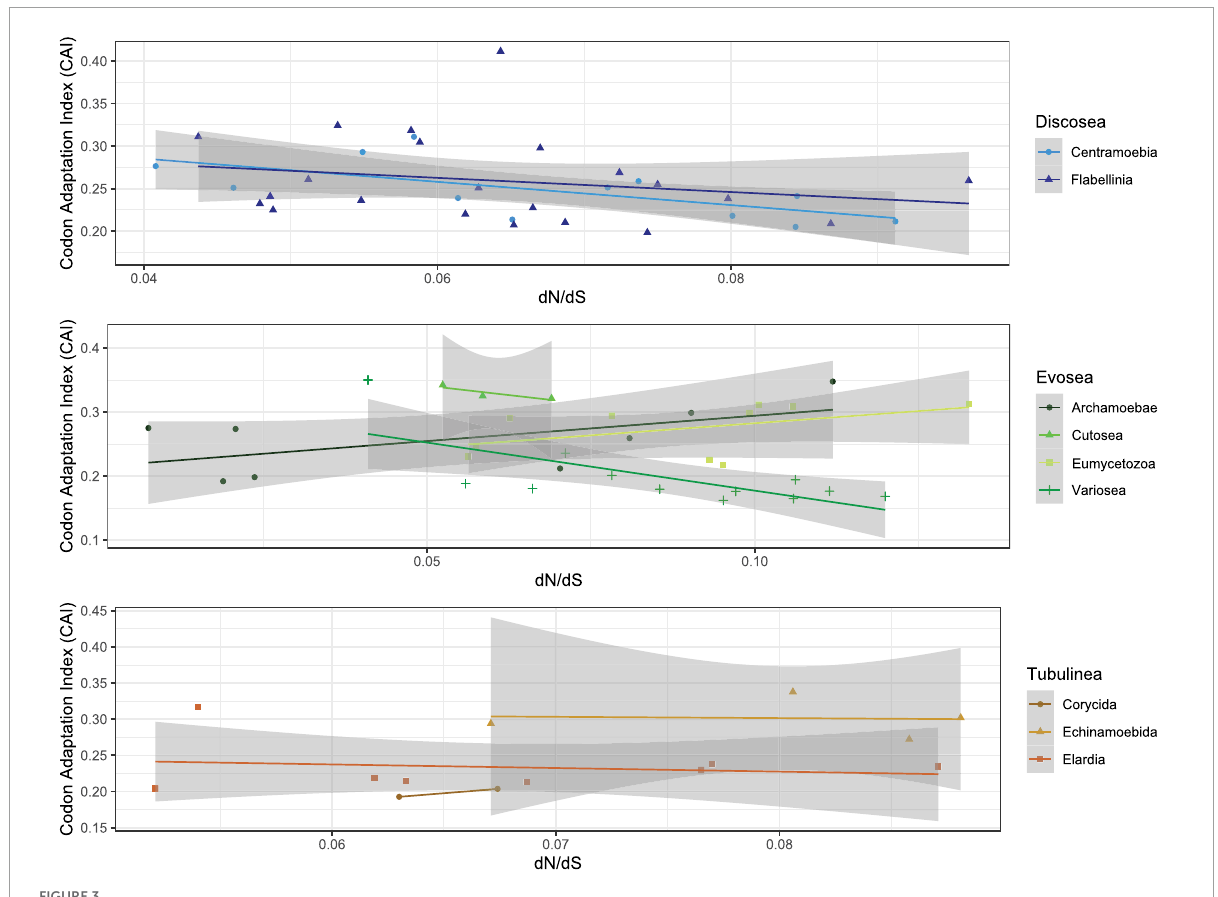
FIGURE3 Correlation of dN/dS and Codon Adaptation Index in different subclades of